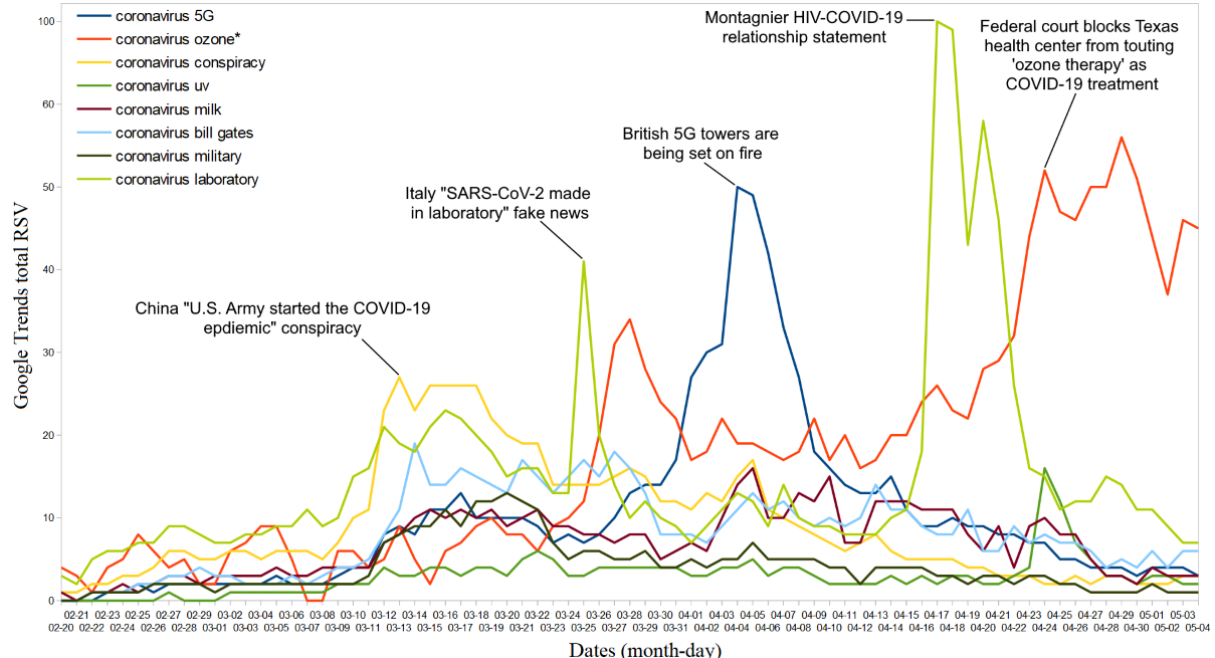
Figure 3. Top global web searches related to coronavirus disease (COVID-19), rated "high" or "extreme" on the infodemic scale, and associated events. RSV: relative search volume.